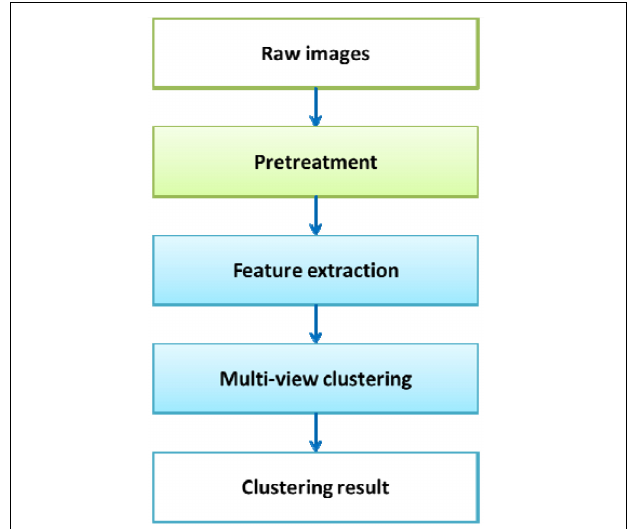
FIGURE 4 | B-MRI-IS process based on multiview clustering.